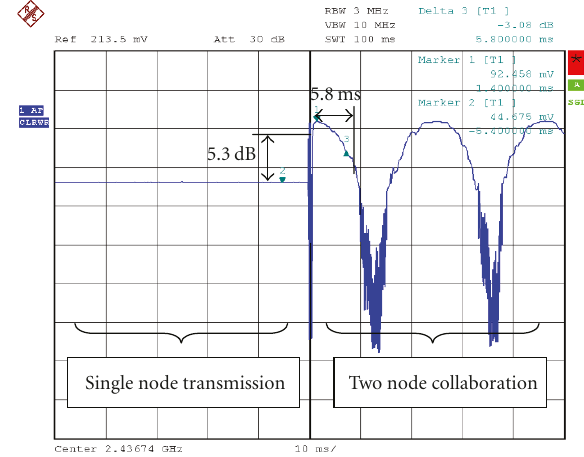
Figure 8: The measured received power for two-node collabora- tion.